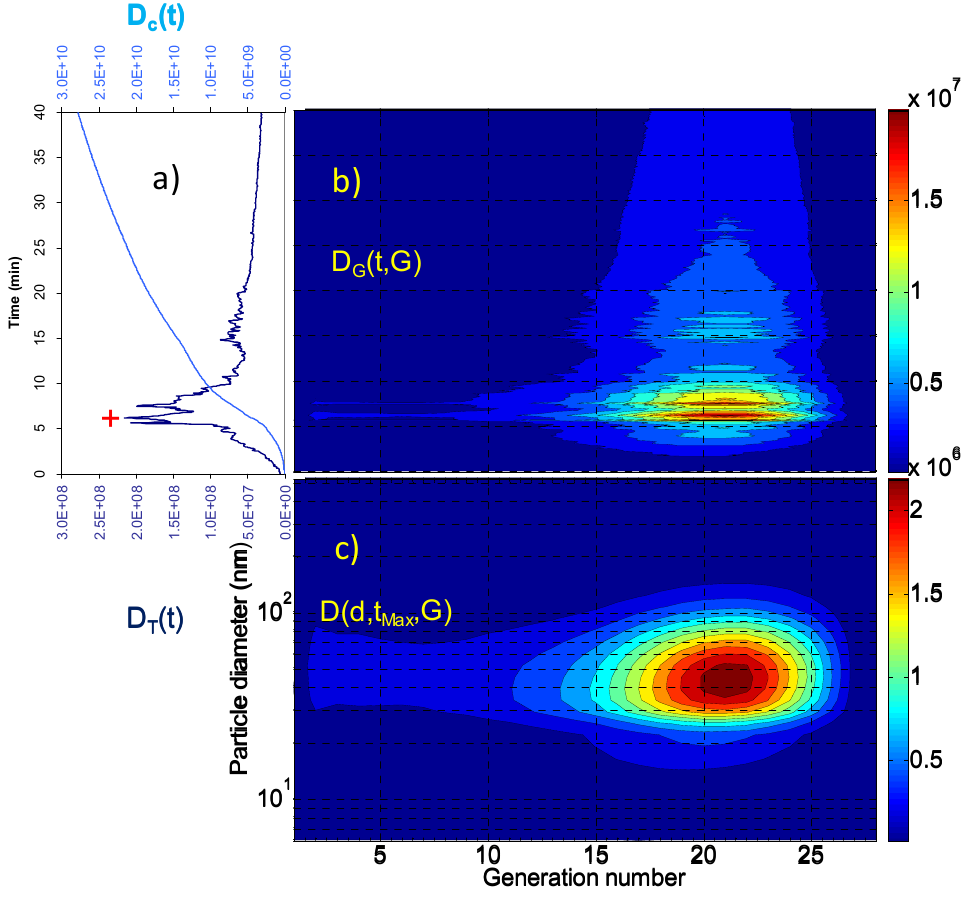
Figure 8. Kitchen, dinner preparation and eating room: ( a ) total instant dose D T (t) and cumulative dose D c (t) as a function of time; ( b ) instant dose per airway generation D G (t,G) as a function of time and airway generation number; ( c ) maximum instant dose D(d,t Max ,G) at the maximum D T (t) value (the red cross in (a)) as a function of particle diameter and of airway generation